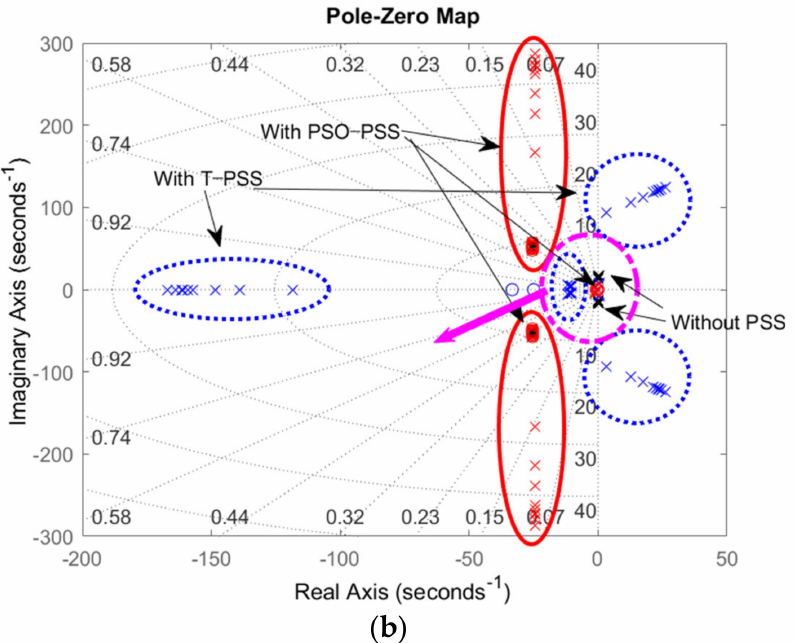
Figure 8. Stability analysis of and single-machine non-stiff bus (SMNB) model depending on the parameter of PSS-2B (red solid line is the PSS tuned by PSO, blue dashed line is the PSS with typical parameters, black dotted line is the case without a PSS): ( a ) Bode diagram of the generator-exciter-PSS (GEP) model and ( b ) pole location of the SMNB